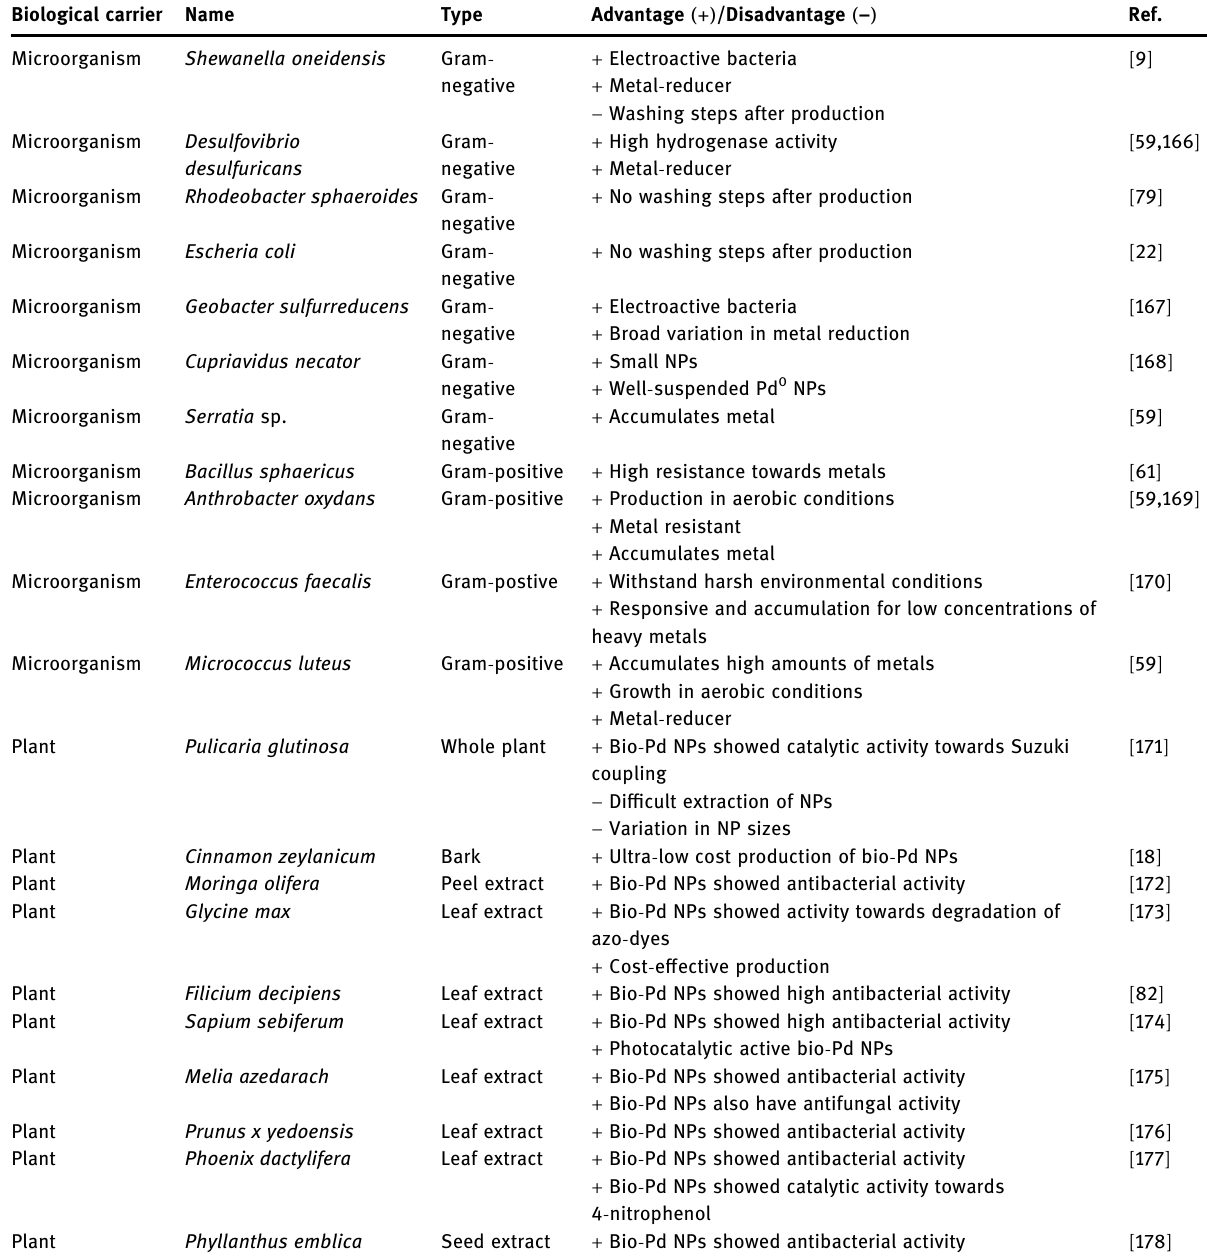
Table 2: Overview of used microorganisms and plants for the production of bio - Pd with the corresponding characteristics Biological carrier Name Type Advantage (+) /Disadvantage ( – )